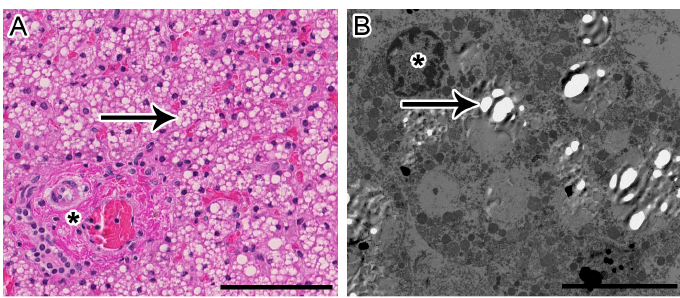
Figure 2. ( A ) H & E staining of the liver, showing unremarkable portal fields (asterisk) but extensive, fine, and coarse intracytoplasmic droplets (arrow; scale bar 100 µ m); Electron microscopy ( B ) identified these droplets (arrow) as predominantly intracytoplasmic lipid droplets (nucleus of a cell shown by asterisk; scale bar 10 µ